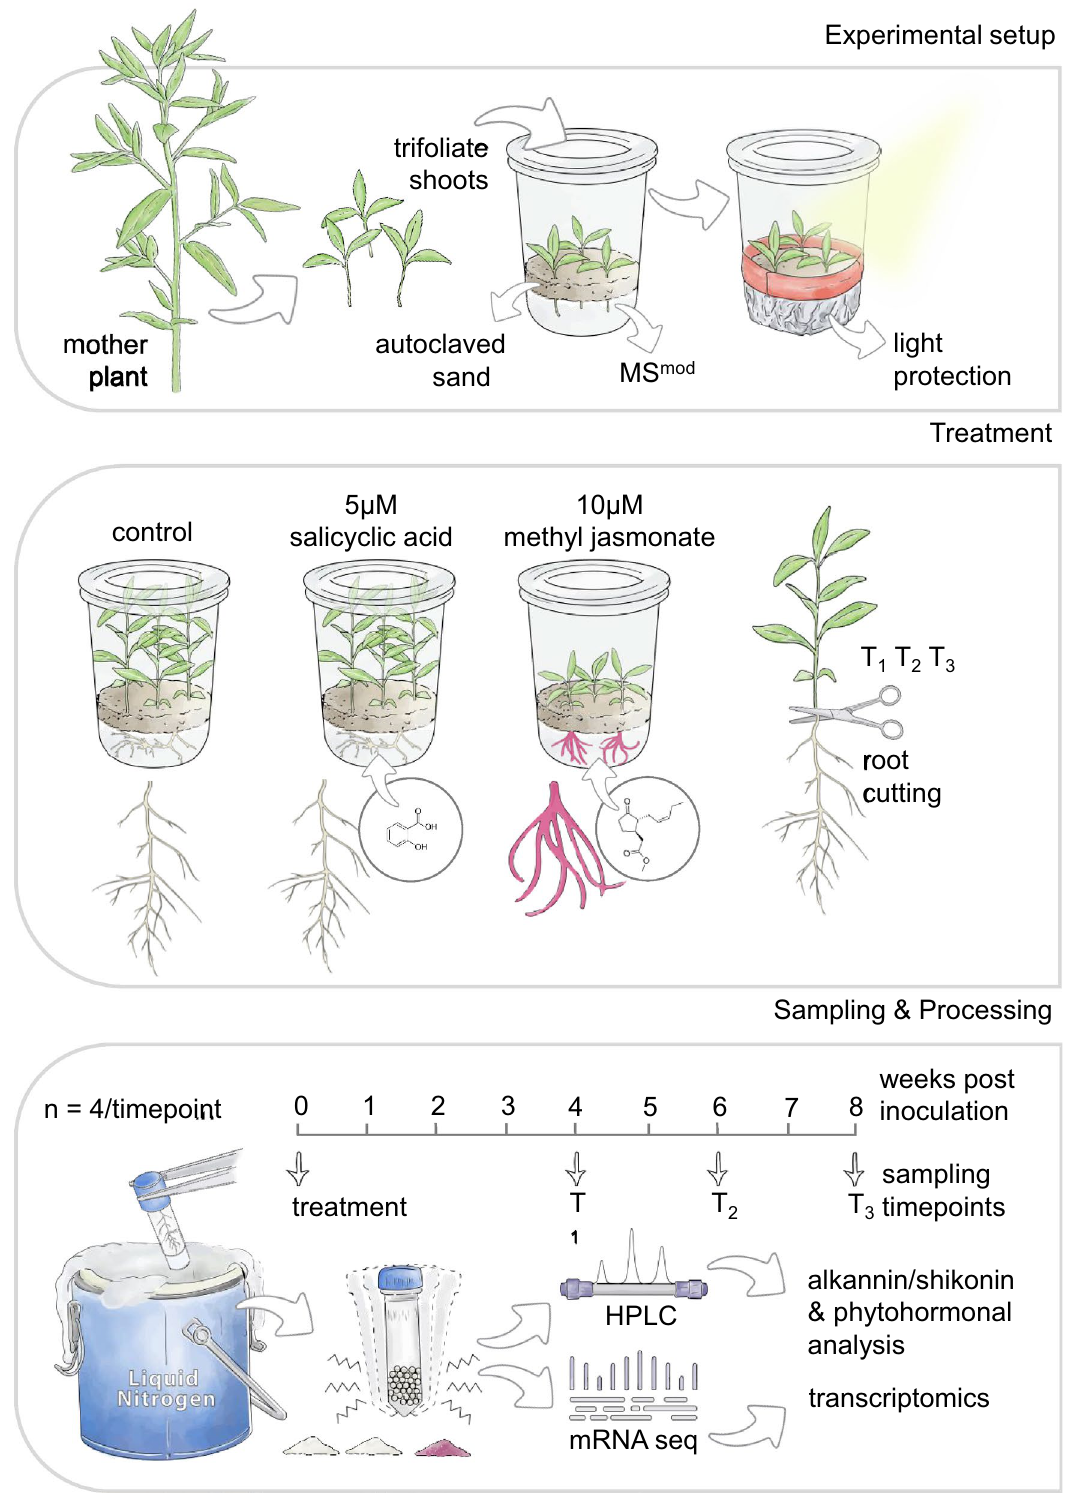
Figure 2. Study system, experimental setup and sampling scheme to investigate the effect of MeJA and SA on A/S biosynthesis in Lithospermum officinale . Shoot cuttings of L. officinale were transferred to MSR modified medium supplemented with MeJA or SA. The roots and shoots of three to five replicates were harvested at 4 weeks post inoculation (wpi), 6 wpi and 8 wpi, and were used for metabolite analysis and mRNA sequencing. Designed by Tatjana Hirschmugl (https:// scill ustra tion. at/